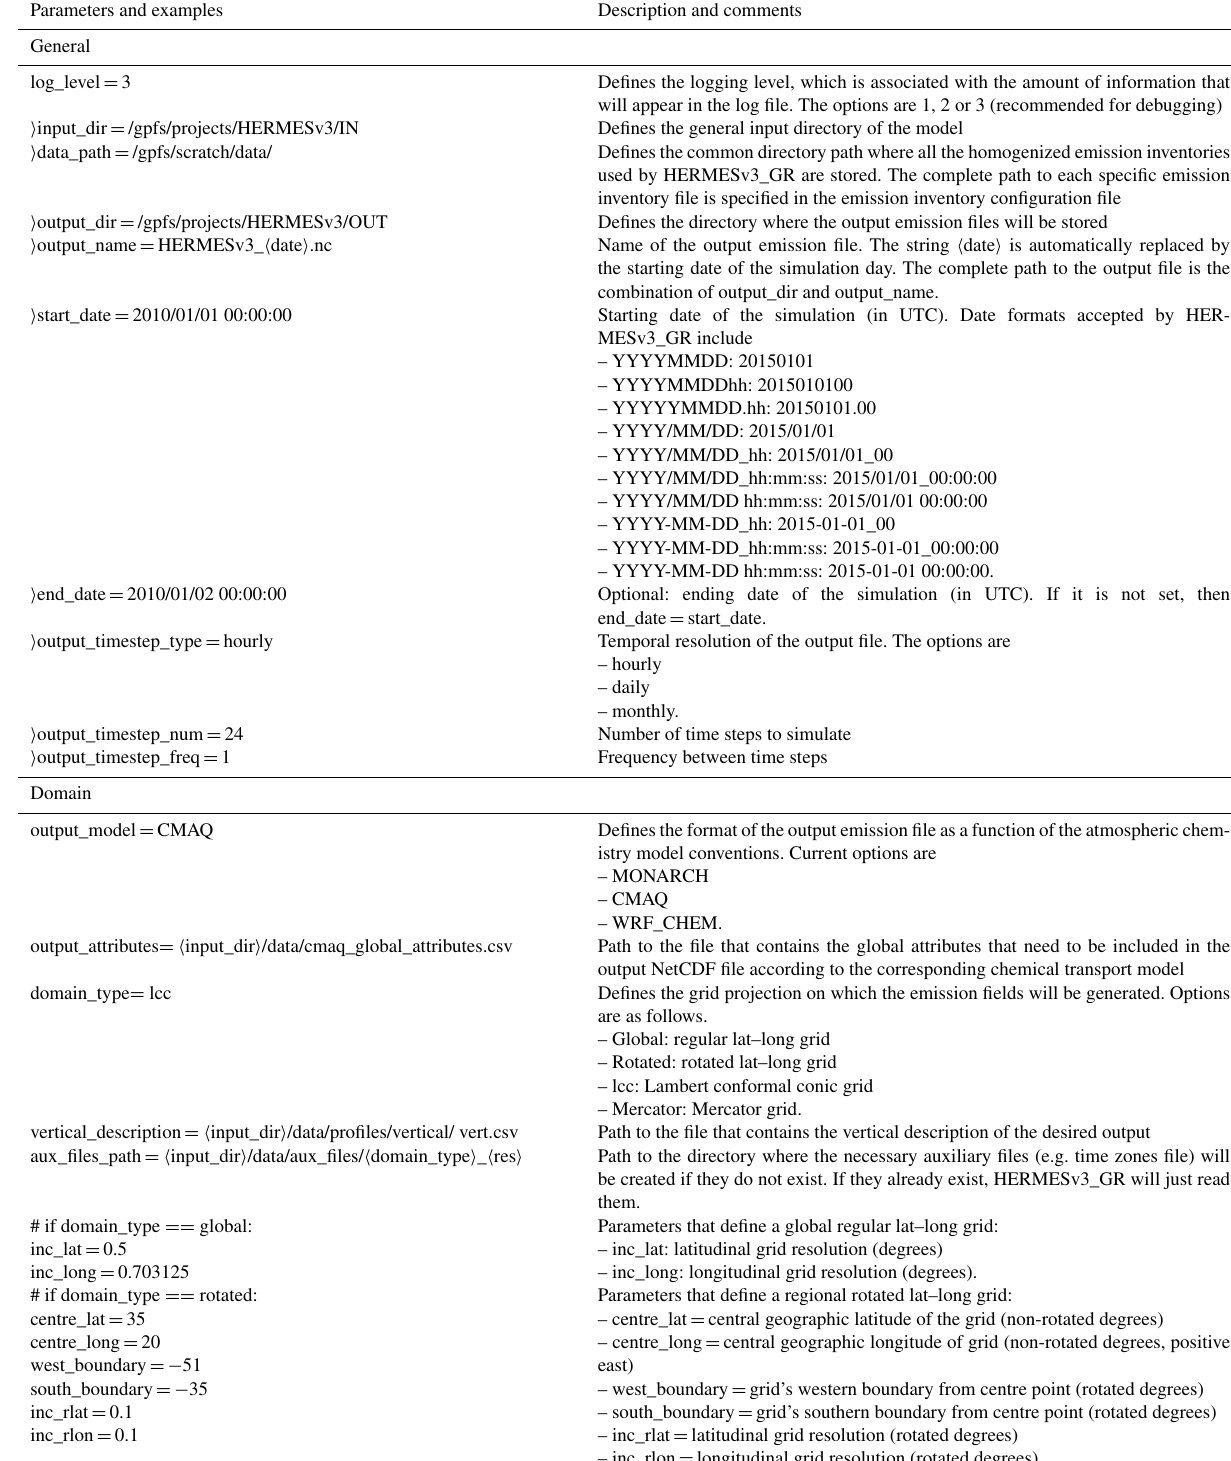
Table A1. HERMESv3_GR general configuration file ( hermes.conf